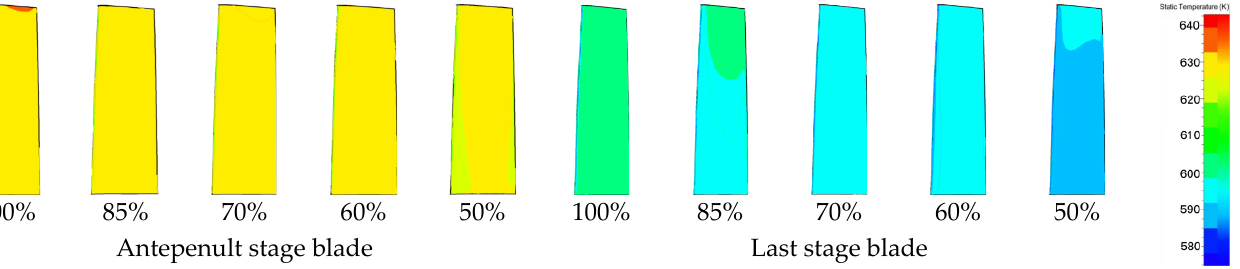
Figure 17. Static temperature distribution on M-P surfaces at different loads (2.7 MPa back pressure) .